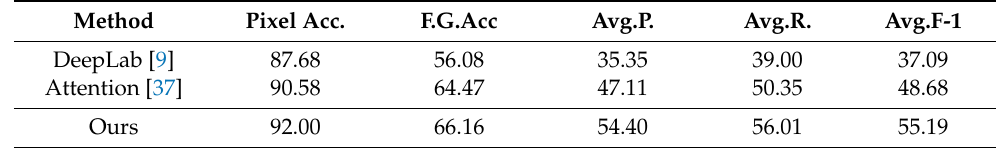
Table 3. Comparison of different methods on the test of Fashion Clothing.